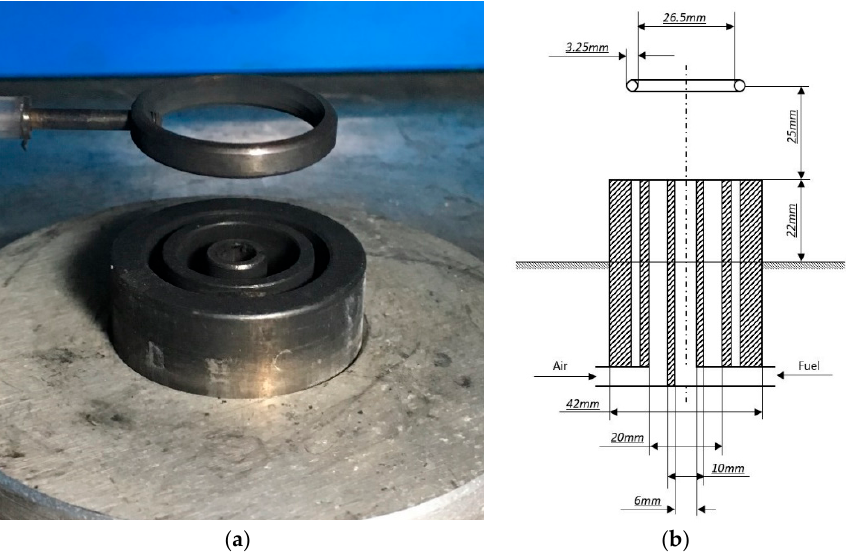
Figure 2. ( a ) Burner and electrode; ( b ) size and location in